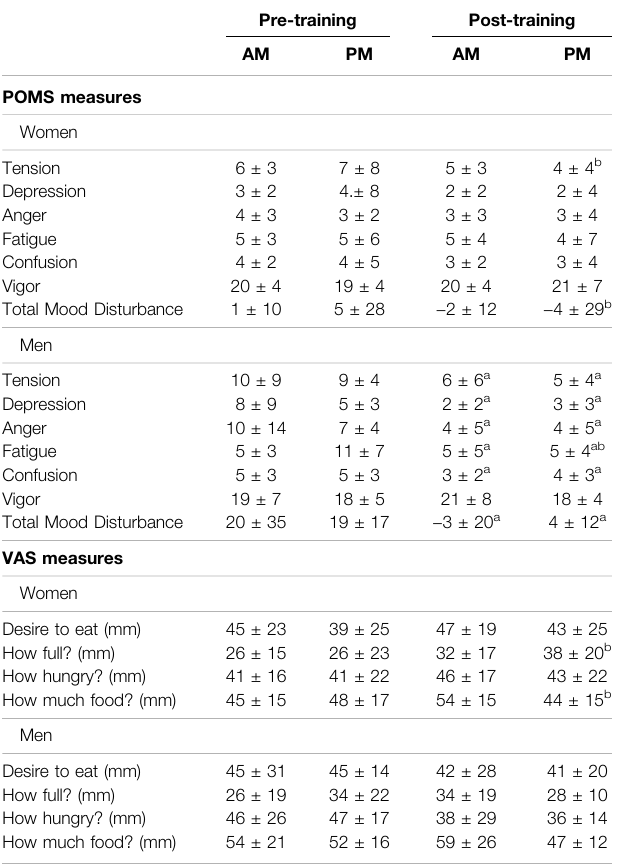
TABLE 5 | Pro fi le of Mood States (POMS) and Visual Analog Scale (VAS) changes between AM vs PM exercisers during the 12-weeks RISE Exercise Intervention for women and